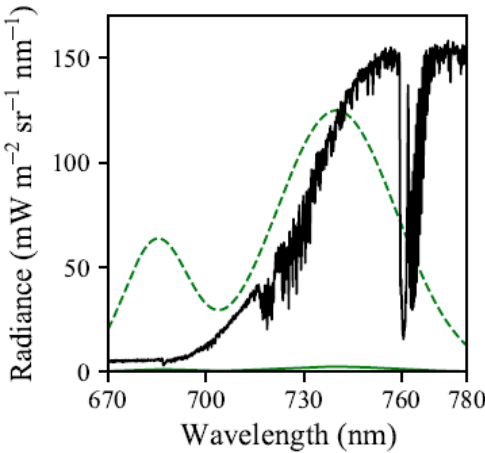
Figure 1. A sample of upwelling radiance of vegetation observed from fluorescence imaging of red and far-red light yield (FIREFLY) (black line), accompanied by an example SIF function to scale (green line), and the same solar induced fluorescence (SIF) function multiplied by a factor of 100 (green dashed line) to show the position of the peaks.